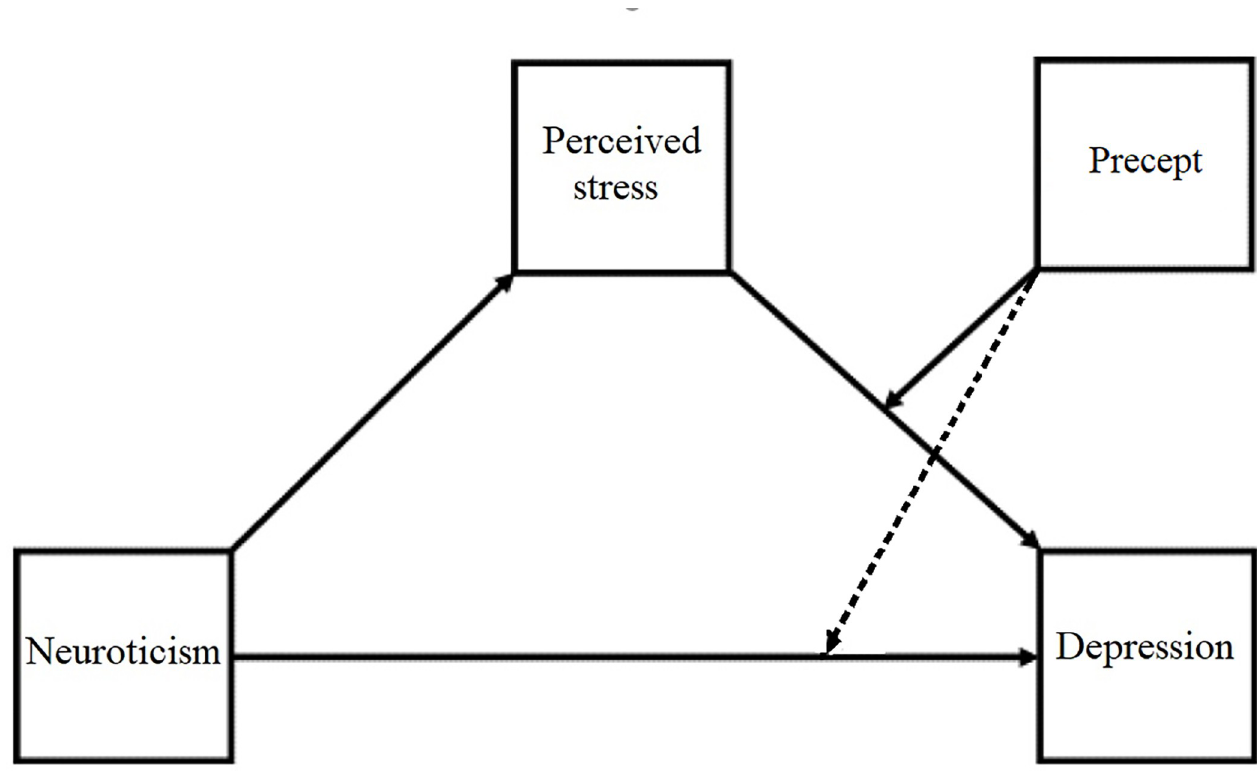
Fig 4. Possible moderated mediation models (Model 14 and Model 15). Legend: Model 14 (excluding the dotted line) and Model 15 (including the dotted line).